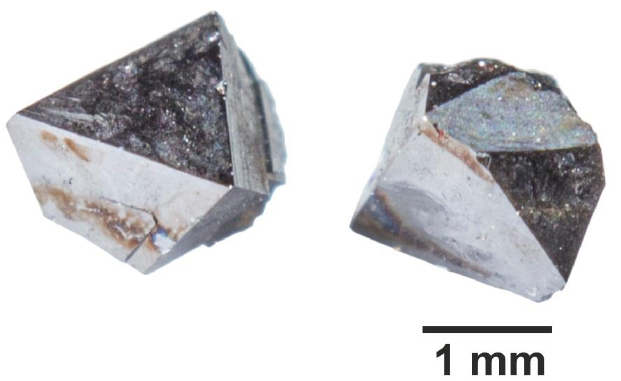
Figure 1. Crystals of magnetite synthesised (conditions — 450 °C, 1 kbar, NH 4 Cl solution) displaying prevailing crystal habit.